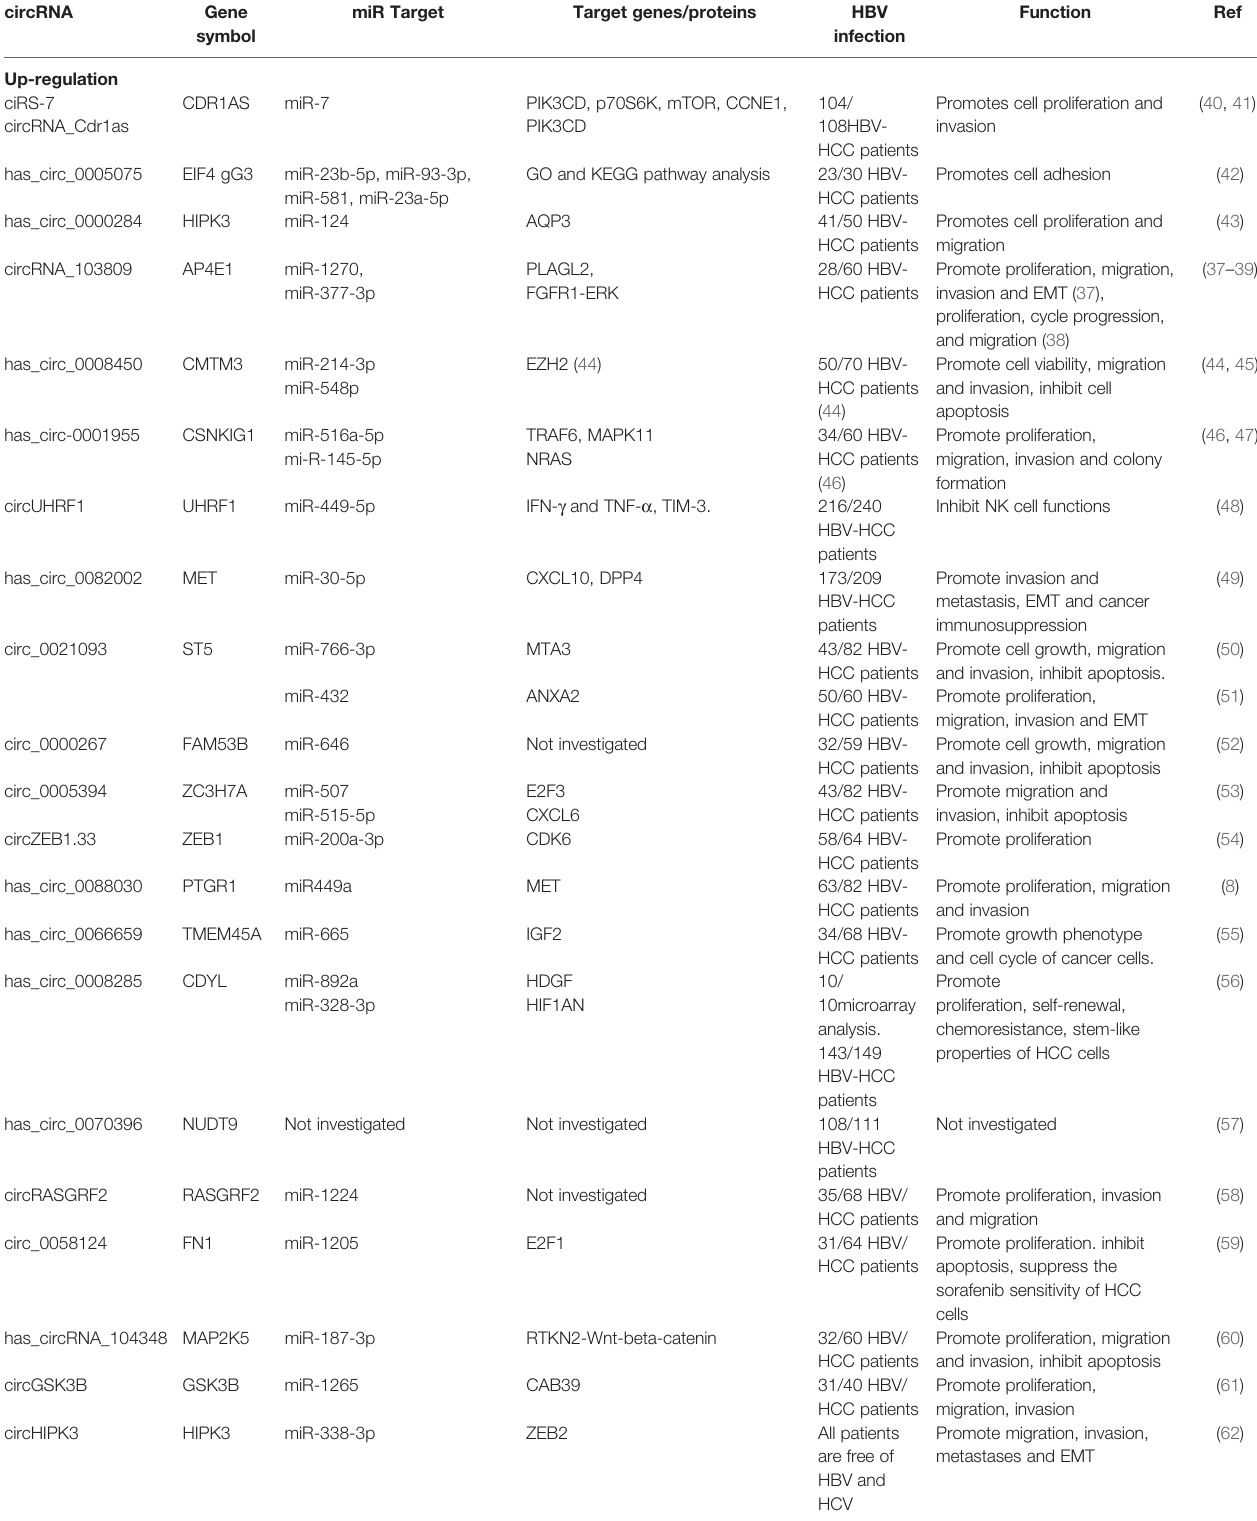
TABLE 2 | Summary of circular RNA in non- and potential HBV infected hepatocellular carcinoma population.